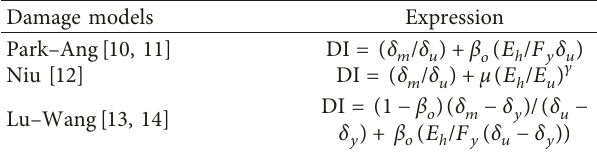
Table 1: The DPDMs adopted in this study. Damage models